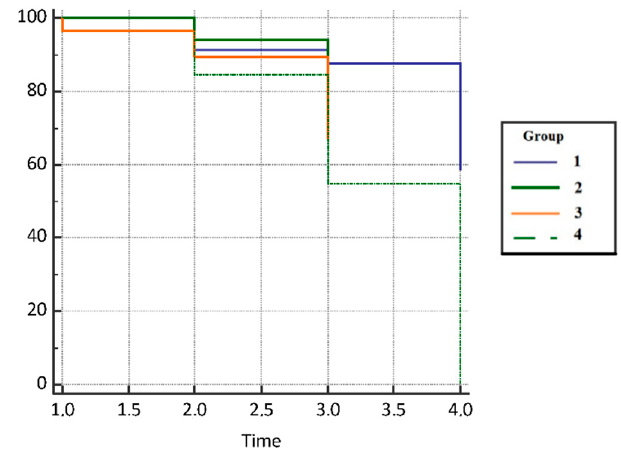
Figure 5. Disease control rate (DCR) in analyzed groups of patients. Table 5. Hazard ratios (HR) with a 95% confidence interval.